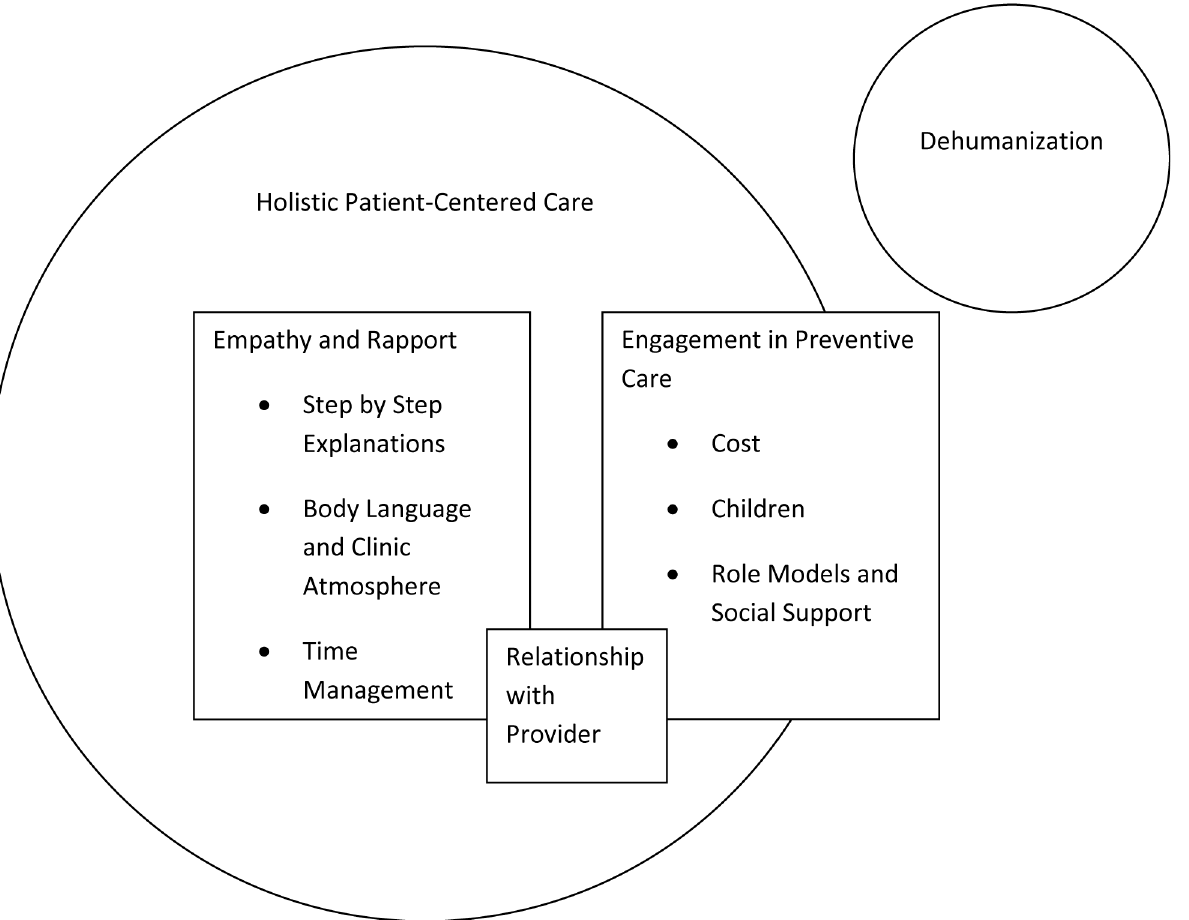
Fig 1. Relationship between dehumanization and the elements of holistic patient care based on content analysis of interview